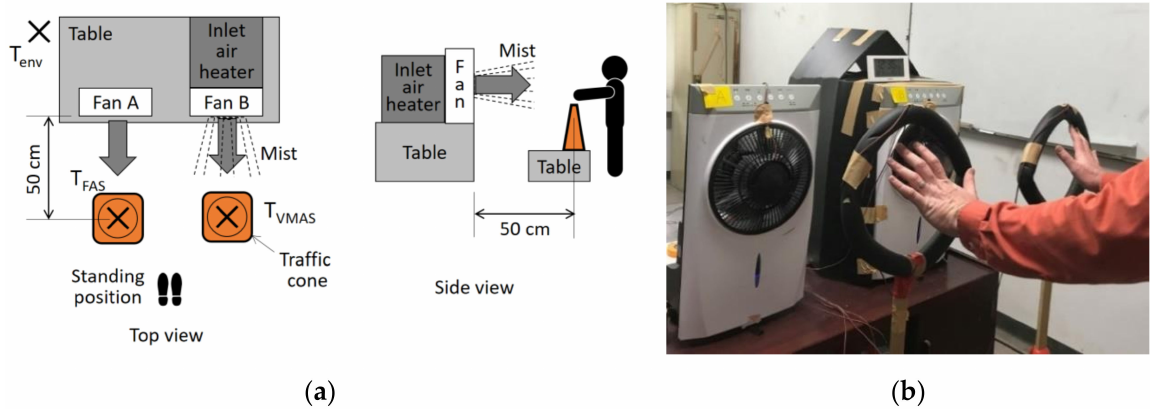
Figure 3. ( a ) Setup of the misting fan experiment. Three “X” marks indicate sensor positions. ( b ) photo of indoor setup and hand placement guide hoops (added for the second and all further